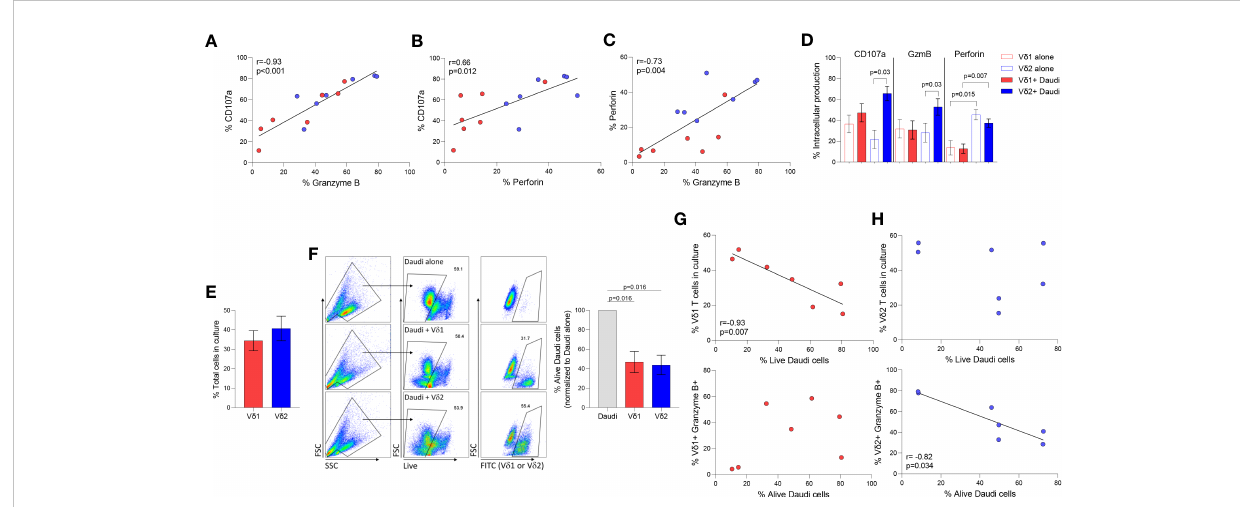
FIGURE 3 Cytotoxic function of gd T cell subsets. Daudi Burkitt ’ s lymphoma cell line was used to compare V d 1 and V d 2 T cells cytolytic function in seven healthy donor volunteers. Correlation between different intracellular markers upon coculture of V d 1 (red) and V d 2 (blue) T cells and Daudi cells, (A) CD107 and GzmB, (B) CD107a and perforin, and (C) Perforin and GzmB. (D) Expression of CD107a, GzmB and perforin in V d 1 and V d 2 T cells. (E) Comparison of the total number of V d 1 and V d 2 T cells during co-culture with Daudi cells (). (F) Comparison of Daudi cell killing capacity of V d 1 or V d 2 T cells. Correlation of killing capacity with (G) V d 1 T cells ’ frequency in culture, and GzmB production. Correlation of killing capacity with (H) V d 2 T cells ’ frequency in culture and GzmB production (r s =-0.82, p=0.034). Mean ± SEM is shown. Daudi cell killing analyzed by Wilcoxon matched-pairs rank test. Correlations by Spearmans ’